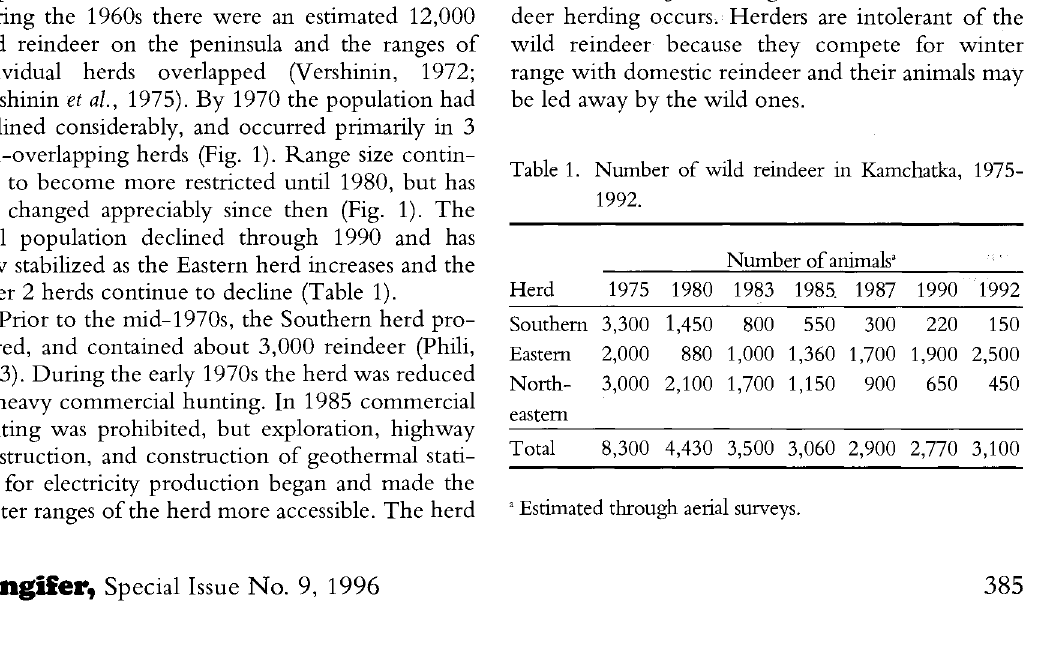
Table 1. Number of wild reindeer in Kamchatka, 1975¬